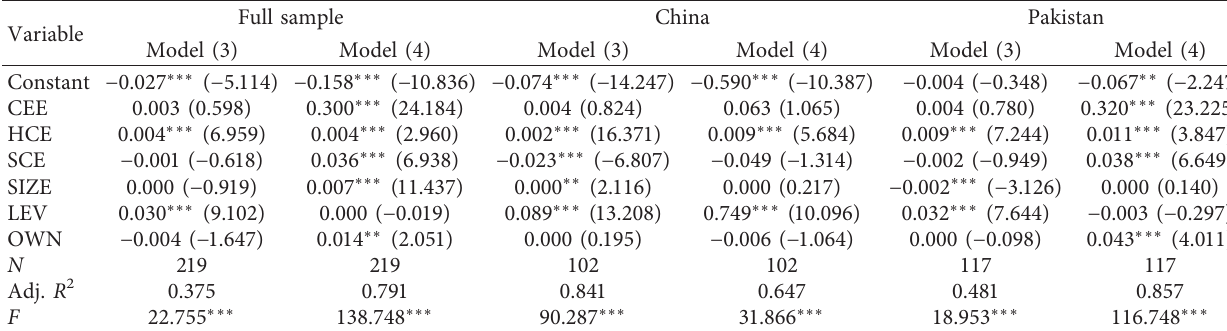
Table 4: Regression results of Models (3) and (4).